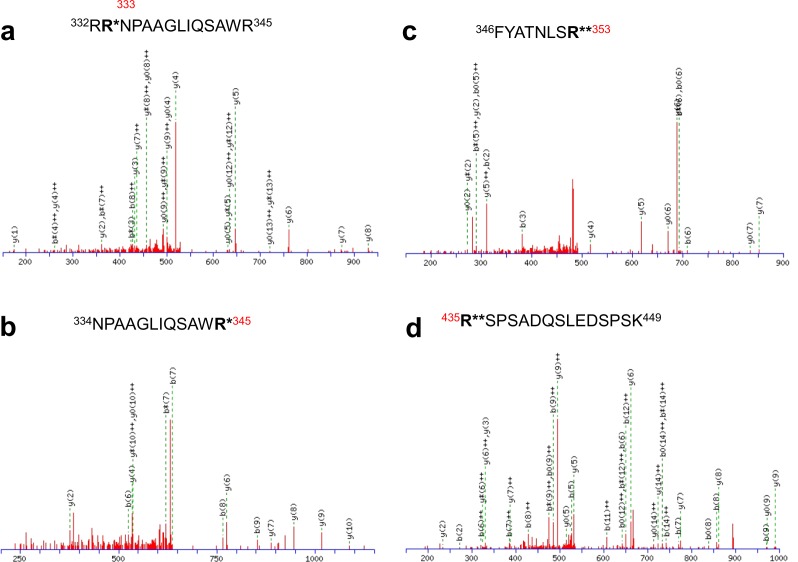
Identification of in vivo arginine methylation sites of KCNQ2 MS/MS spectra of the methylated peptides.(a) 332RRNPAAGLIQSAWR345, (b) 334NPAAGLIQSAWR345, (c) 346FYATNLSR353 and (d) 435RSPSADQSLEDSPSK449. R* represents monomethylated arginine and R** represents dimethylated arginine.